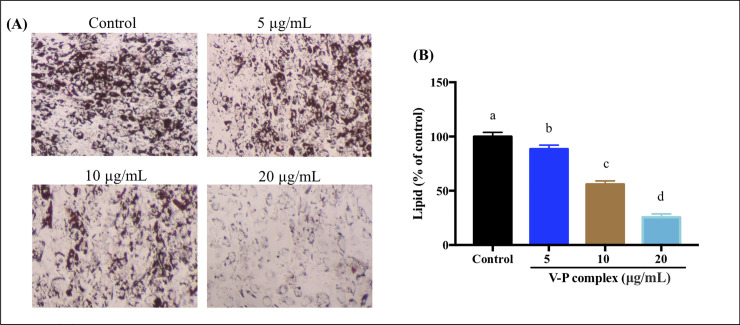
Effect of V-P complex on cellar lipid droplets.(A) Confluent human preadipocytes were induced to differentiate in DM containing different concentrations of V-P complex for 14 days (B) Oil red O were extracted and quantified by measuring the absorbance at 490 nm. All values present the mean ± SD (n = 5) of three independent experiments. a, b, c, d Different letters indicate a significant difference (p< 0.05) within the graph.